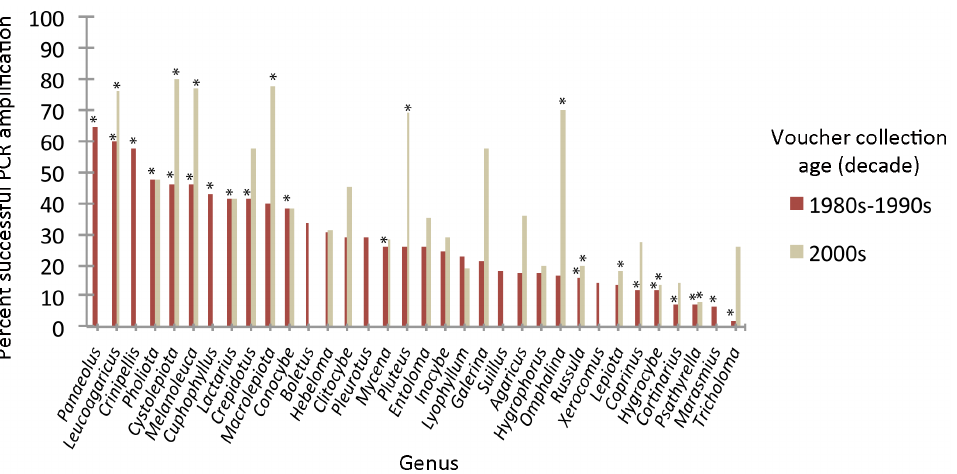
Figure 2. Association between taxon (controlled for specimen age) and PCR amplification success using primers ITS1F and ITS4. Pearson Chi-square test of independence: p , 0.0001. Asterisks denote categories with standardized adjusted residuals significant a =0.05. See Table S3 for data and post hoc test results.